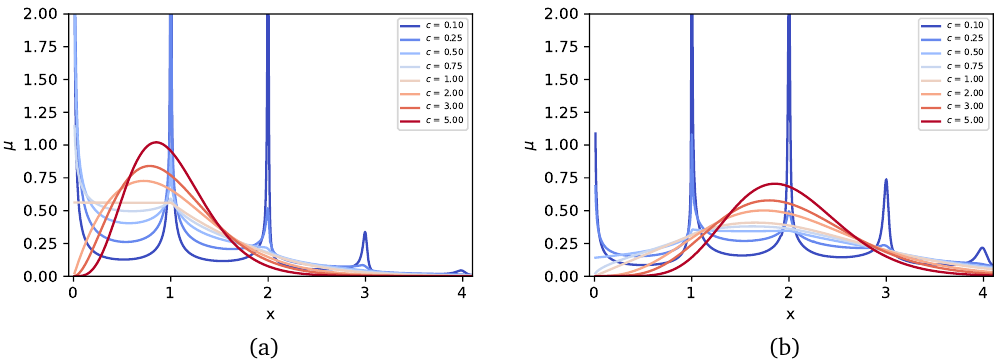
Figure 4: Plots of the Markov-Krein transforms of the limiting distributions of the Poisson limit theorem with parameters a = 1 , λ = 1 in ( a ), λ = 2 in ( b ), for different values of c .